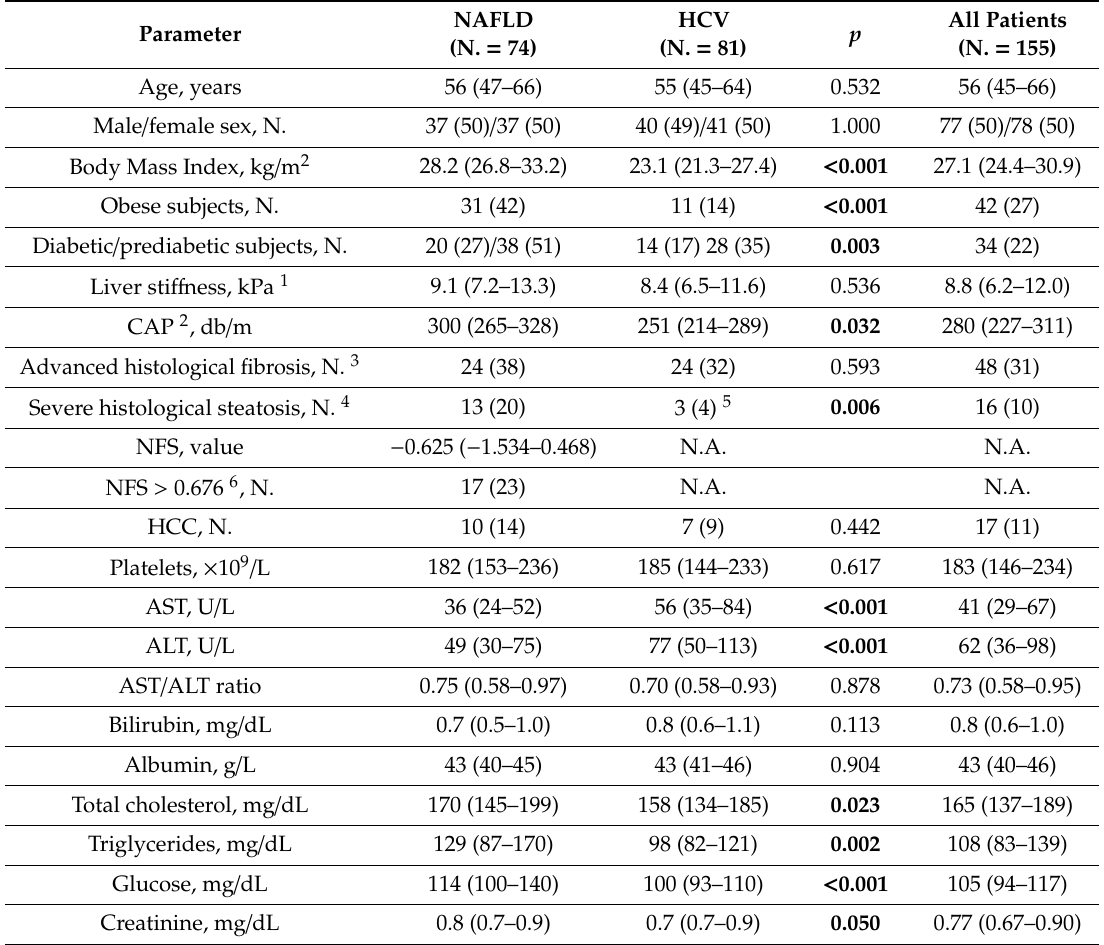
Table 2. Comparison of the main demographic and clinical features of the studied population according to the etiology of liver disease. Data are presented as medians (range) for continuous variables, and as frequencies (%) for categorical variables. The p value refers to the comparison between NAFLD and HCV